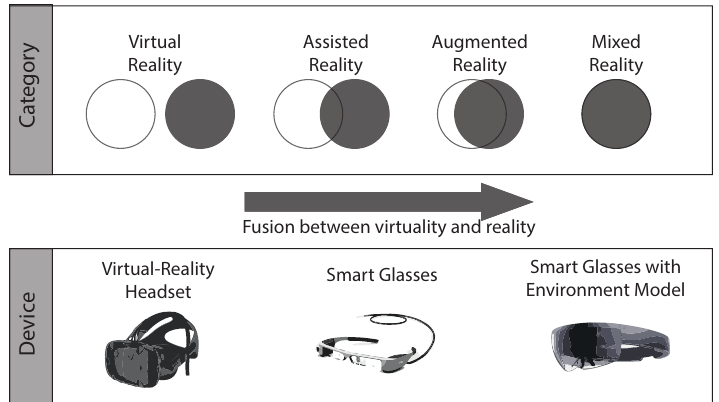
Figure 2. Reality–Virtuality continuum at a glance. The overlap of virtuality and reality increases towards the right-hand side of the figure, the complexity of the necessary devices,